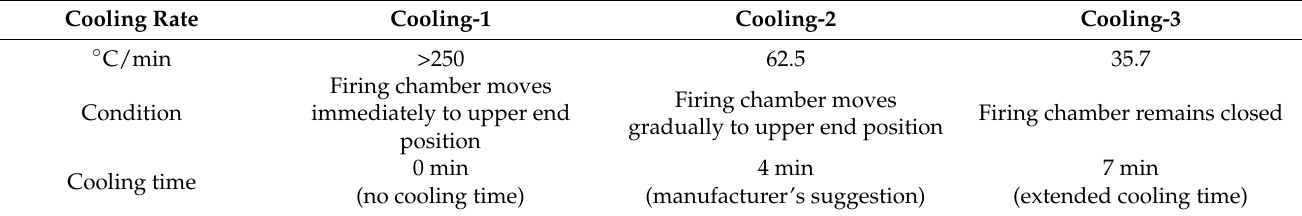
Table 2. Cooling rate during